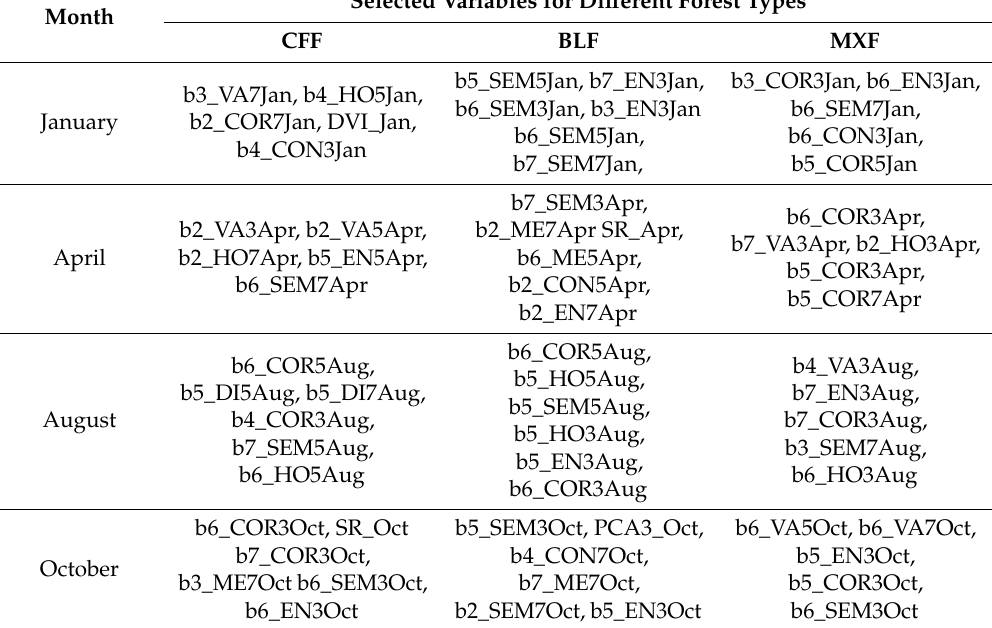
Table 7. The selected variables for AGB estimation models in di ff erent months based on di ff erent forest